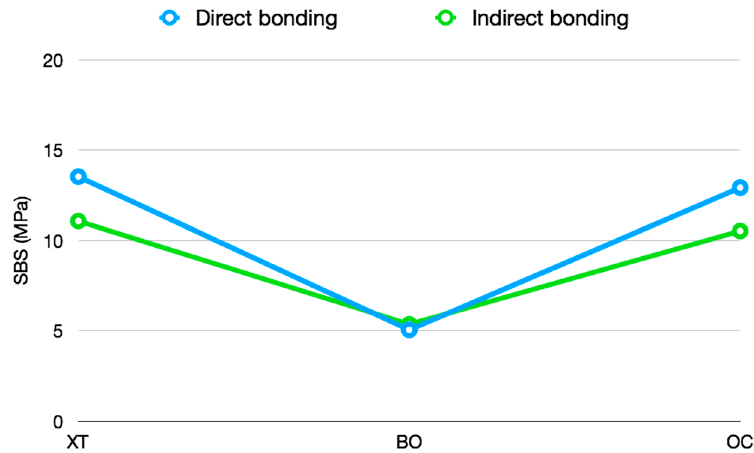
Figure 4. Mean of bonding technique interactions according to the levels of the factors material and bonding technique. Table 4. Comparisons of SBS variable for levels of two factors and six study